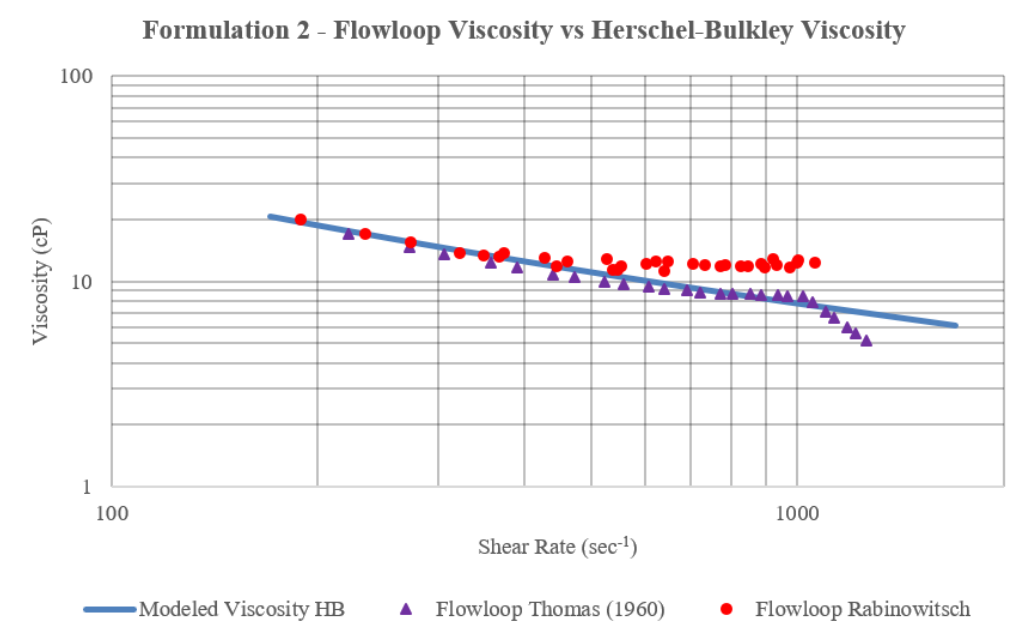
Figure 7: Estimated viscosity of Formulation 2